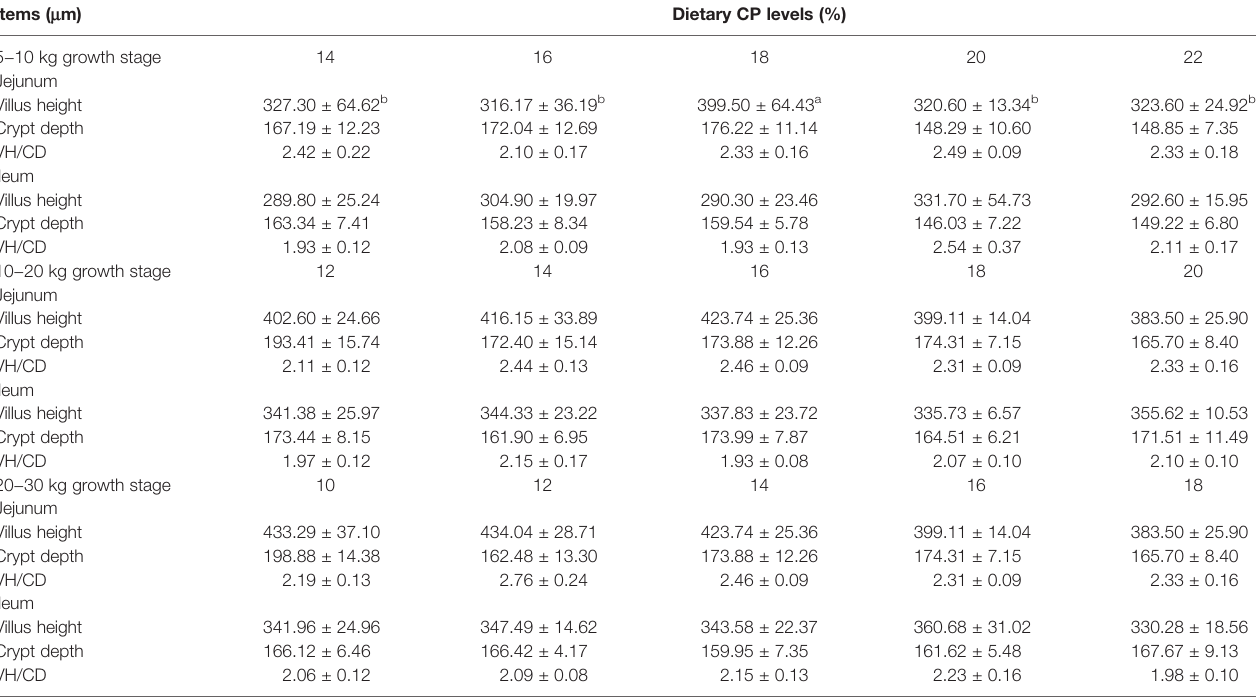
TABLE 2 | Effects of dietary crude protein (CP) levels on the small intestinal morphology of Huanjiang mini-pigs during different growth stages. Items ( m